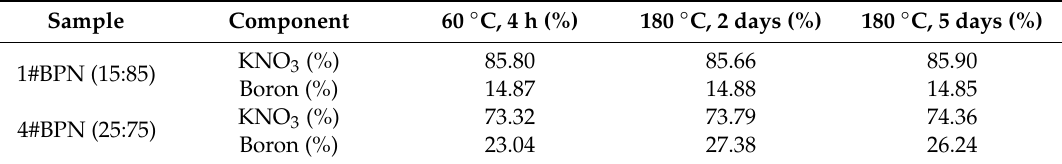
Table 7. Component variation of BPN samples in 180 ◦ C test [18].